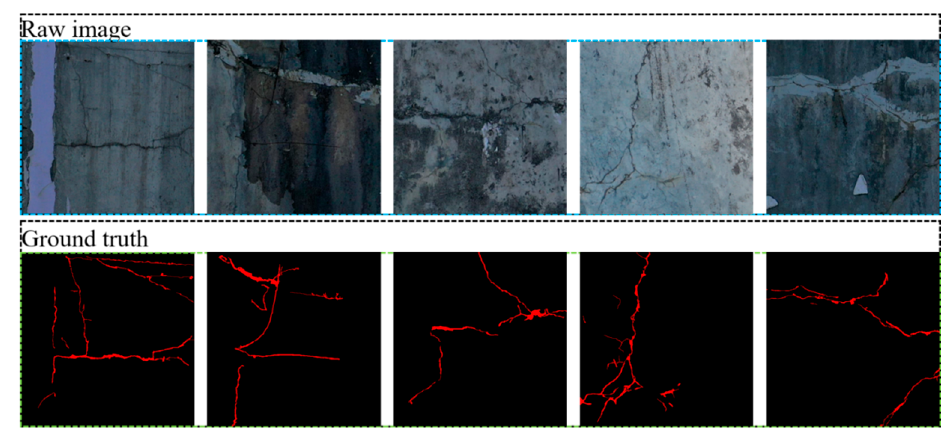
Figure 8. The example of crack images and ground truths for dam surface.